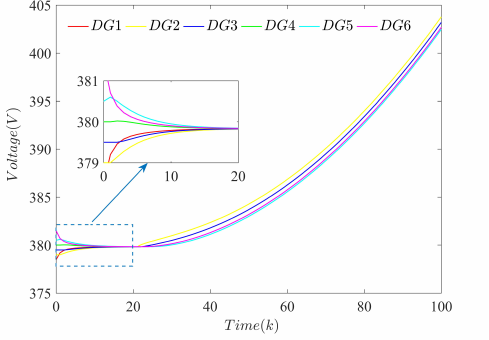
Figure 7. Consensus performance of the DGs using the strategy in [17] under the estimation- dependent attack.